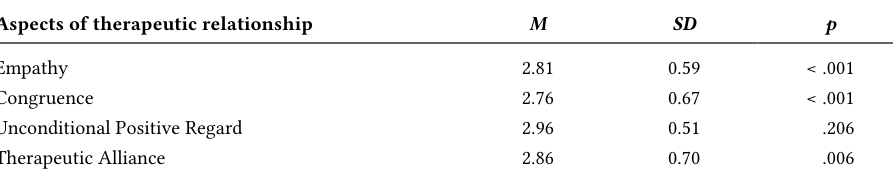
Perceived Effect of Teleconsultation on Therapeutic Relationship as Compared to Face-To-Face (n = 207) (1: highly degraded, 3: no change, 5: highly improved) Aspects of therapeutic relationship